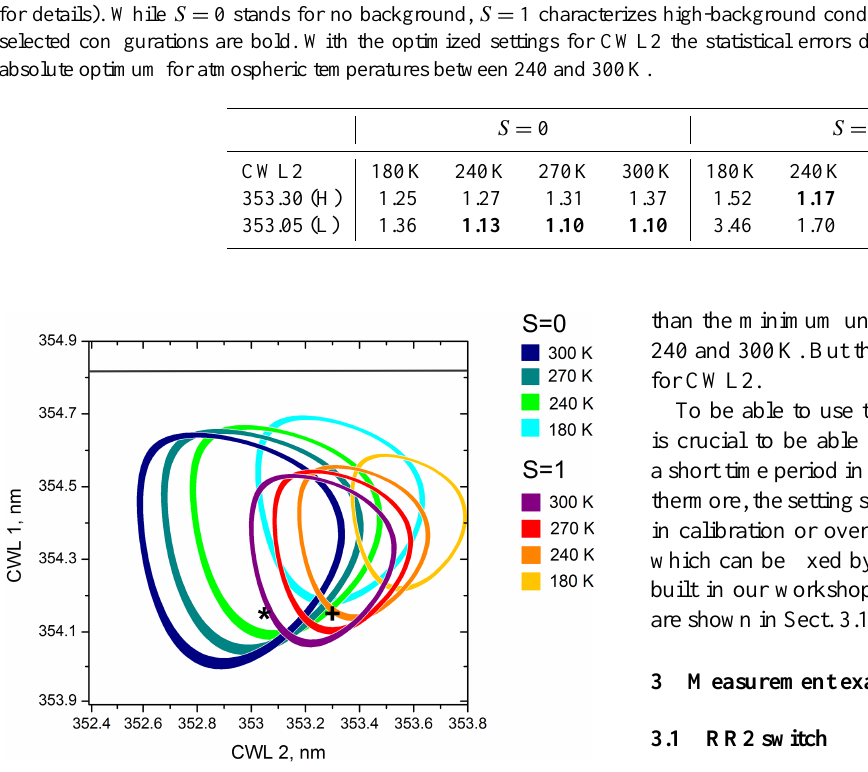
Figure 6. Overview of all cases shown in Fig. 5. The outer and inner borders of the rings mark 1.20 and 1.17 relative uncertainty, respec- tively. The selected configurations for high- and low-background conditions (marked with + and * , respectively) show lower relative uncertainties than 1.2 for all temperatures between 240 and 300K (see also Table 3). The gray line marks the laser